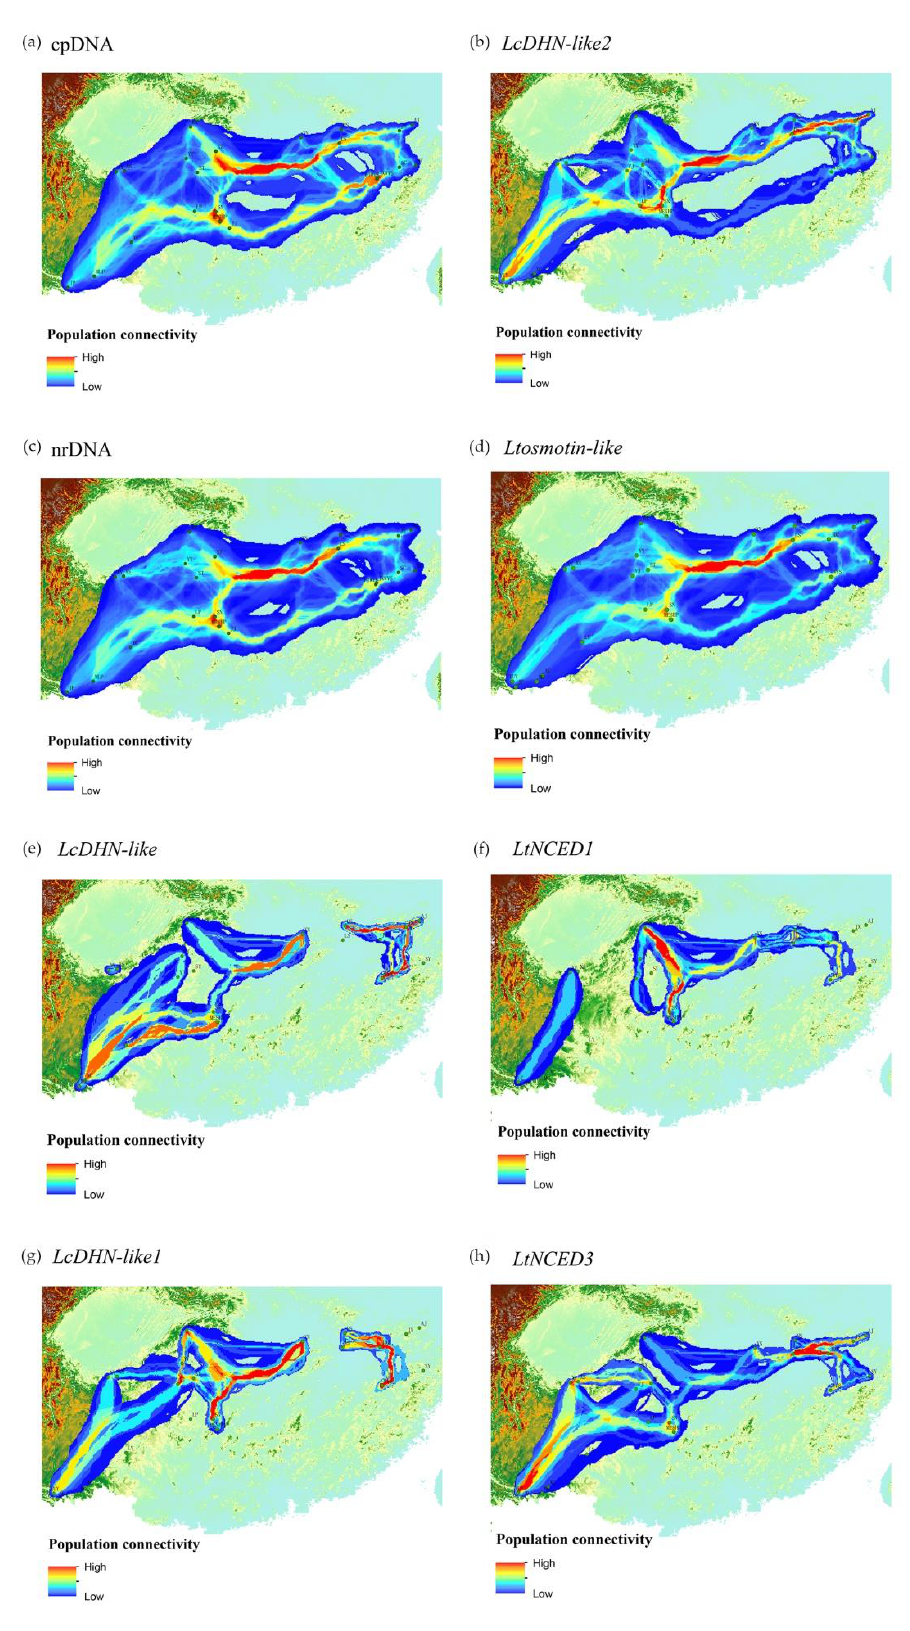
Figure 4. Construction of dispersal networks for L. chinense based on cpDNA, nrDNA, and six nuclear genes sequences ( a – h ). Warmer color depicts higher population connectivity.